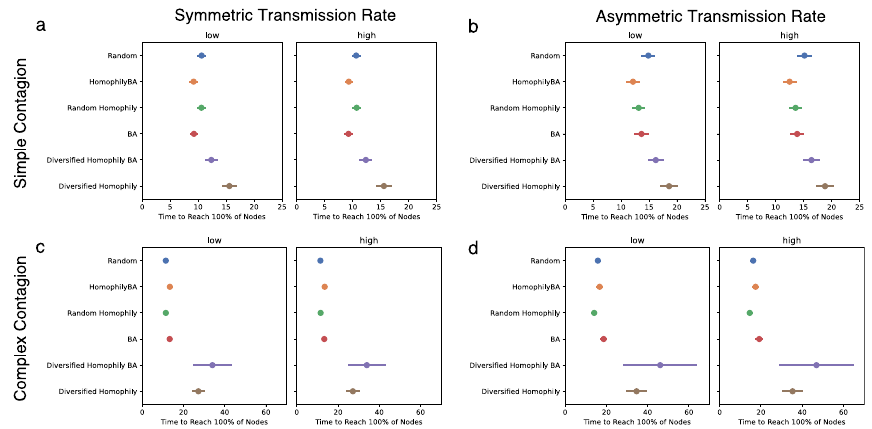
Fig. 9 Information spreading efficiency of different generative models of complex networks. We inspect information access efficiency by looking at the time needed to reach 100% of the nodes. The x‑axis is the time (in the number of iterations) needed to reach 100% of the nodes. The y‑axis is the different generative models. We show the average and standard deviation values of the time needed for 100% outreach across 100K runs for each model and each spreading process. On average, more time is needed with asymmetric transition. Diversified Homophily and Diversified Homophily BA are, on average, slower in spreading information than other models (especially with a complex contagion). This is due to their inter‑group edges. With complex contagion, the standard deviation on time for 100% outreach is larger for Diversified Homophily BA. We conjecture that this is due to the fact that hubs become bottlenecks in complex contagion and Diversified Homophily BA enforces diversification. The hyperparameters used here are the same as in Experiment 1: p d = 0.6 , h = 0.8 , α = 1 , and m = 20% . For a heatmap view of efficiency in information spreading of different generative models, see the Additional file